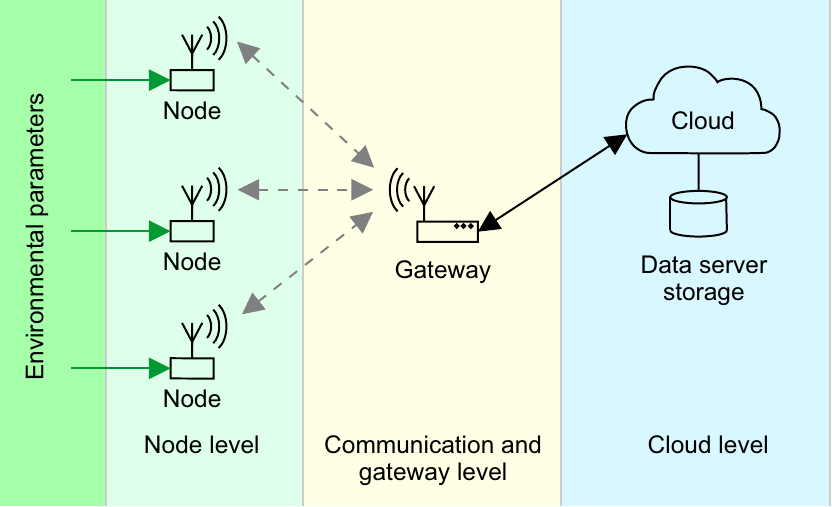
Figure 6. Research challenges: node level, communication and gateway level, and cloud